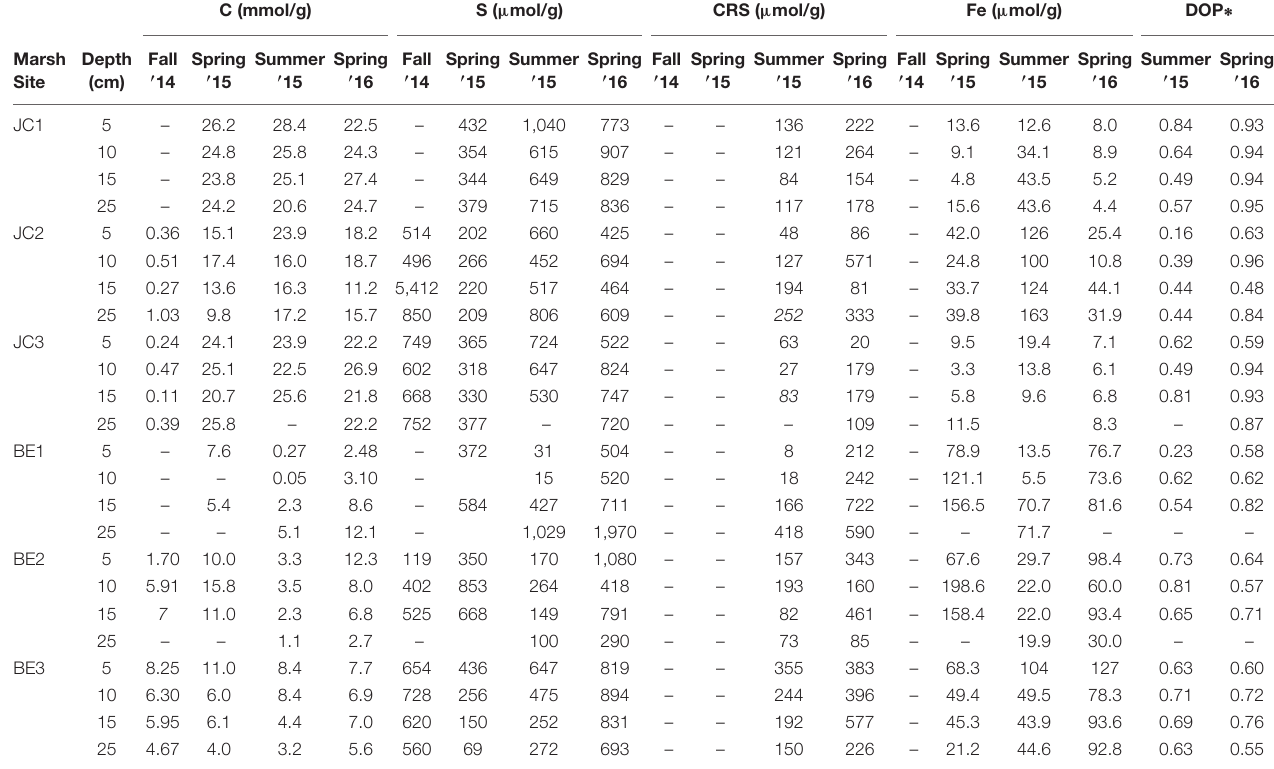
TABLE 3 | Solid phase organic carbon, total sulfur, chromium reducible sulfide (CRS), acid leachable iron and degree of pyritization (DOP) in the marsh sediments of JoCo and Big Egg, Jamaica Bay, NY. C (mmol/g) S ( µ mol/g) CRS ( µ mol/g) Fe ( µ mol/g) DOP